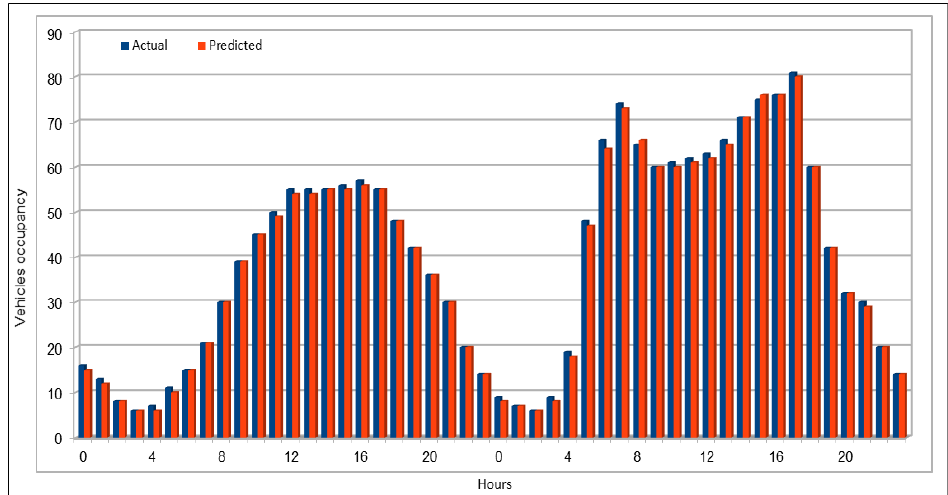
Figure 13. Traffic occupancy: Actual and predicted values for a single